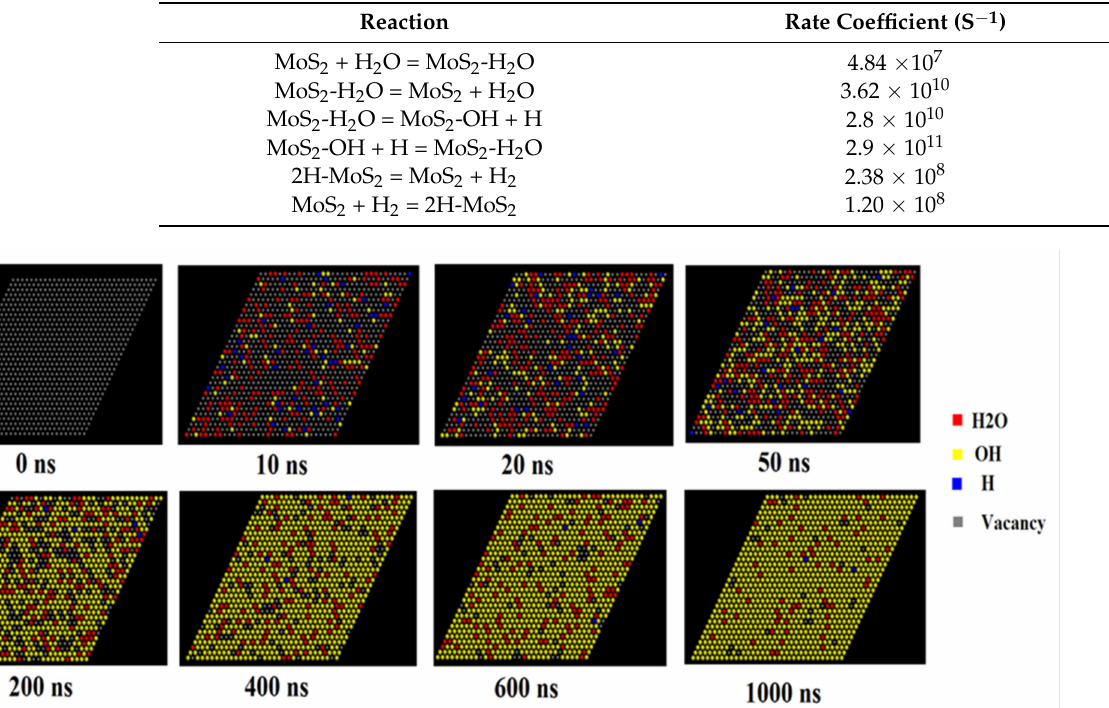
Figure 11. KMC modeling of the dissociative adsorption of H 2 O on the molybdenite (001) surface in one microsecond at 298 K.